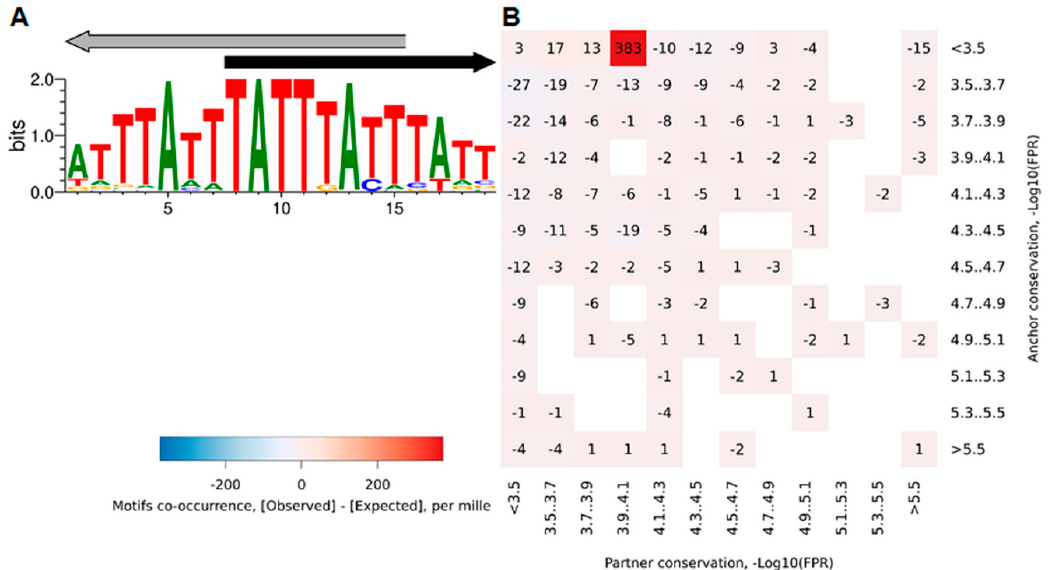
Figure 4. Graphical description of the most common CEs with an overlap of the Anchor FoxA2 and Partner HNF1B motifs for the FoxA2 dataset [18]. ( A ) Logo of the most common CE structural type. Black/grey arrows show the location and orientation of Anchor/Partner motifs. ( B ) Heatmap visualization of relationship of motifs conservation in CEs. Axes X/Y show ranges of conservation level of Partner/Anchor motifs. The color implies the per-mille measure for difference between observed and expected abundances of CEs with specific conservation of motifs (see Section 4.3).